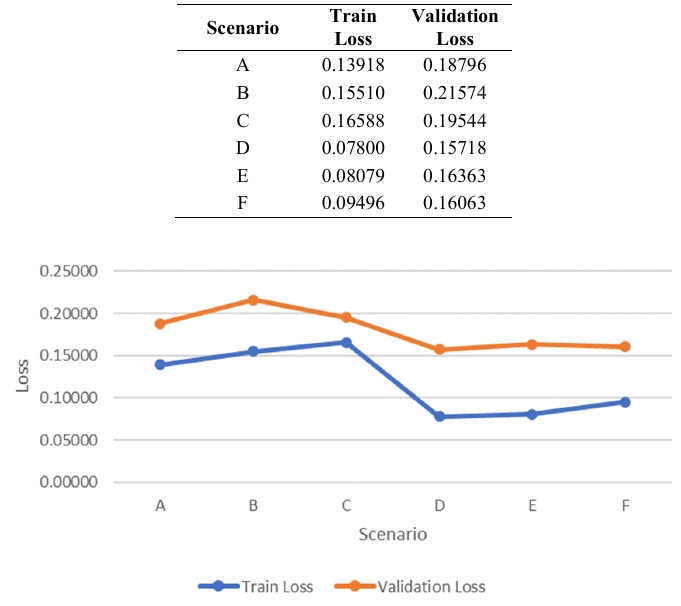
Fig. 8 Graphic of train loss and validation loss obtained by each